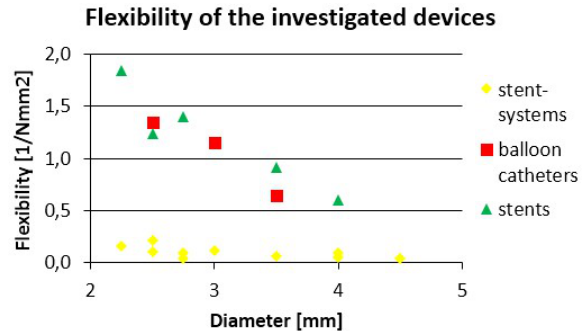
Figure 7. Correlation between flexibility and diame- ter of the investigated